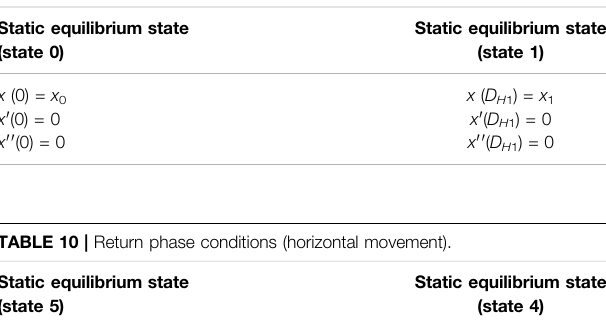
TABLE 9 | Reaching phase conditions (horizontal movement).